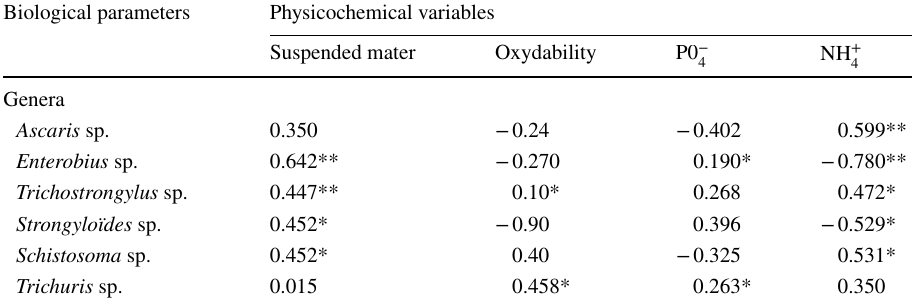
Table 1 Correlations between some physicochemical and biological variables